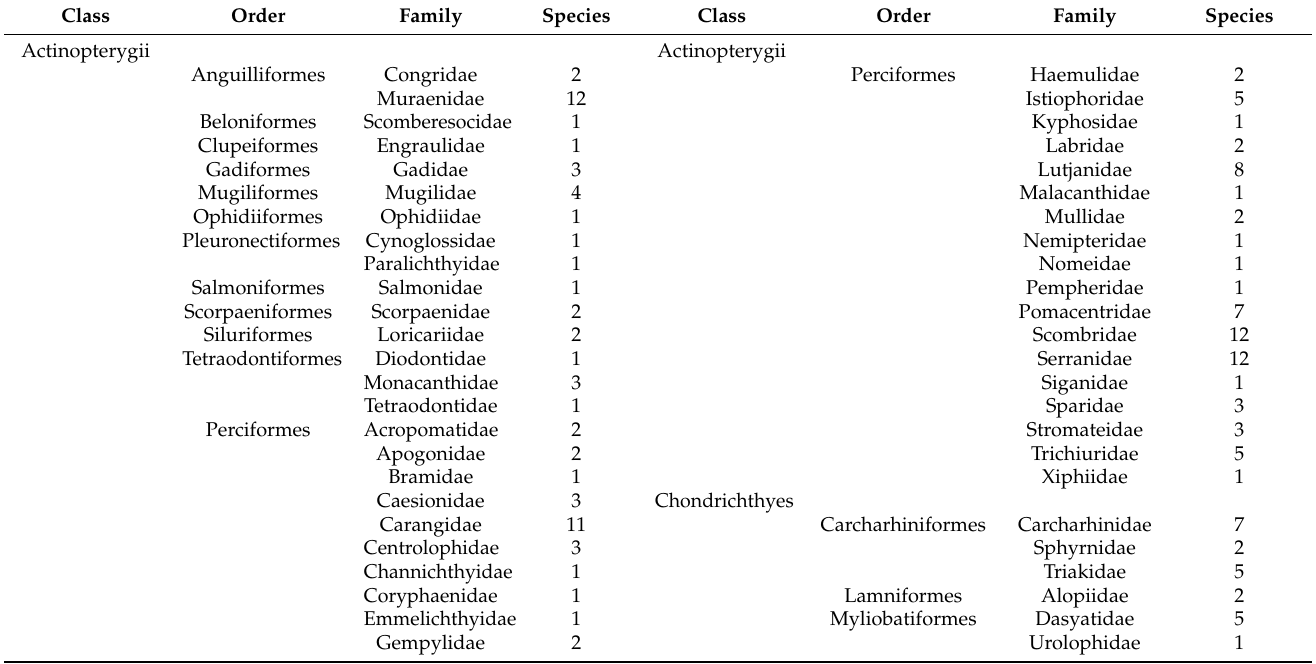
Table 3. Taxonomic classification of 153 fish species identified from eDNA sampling in Heping island fish market and its nearby seafood restaurants.